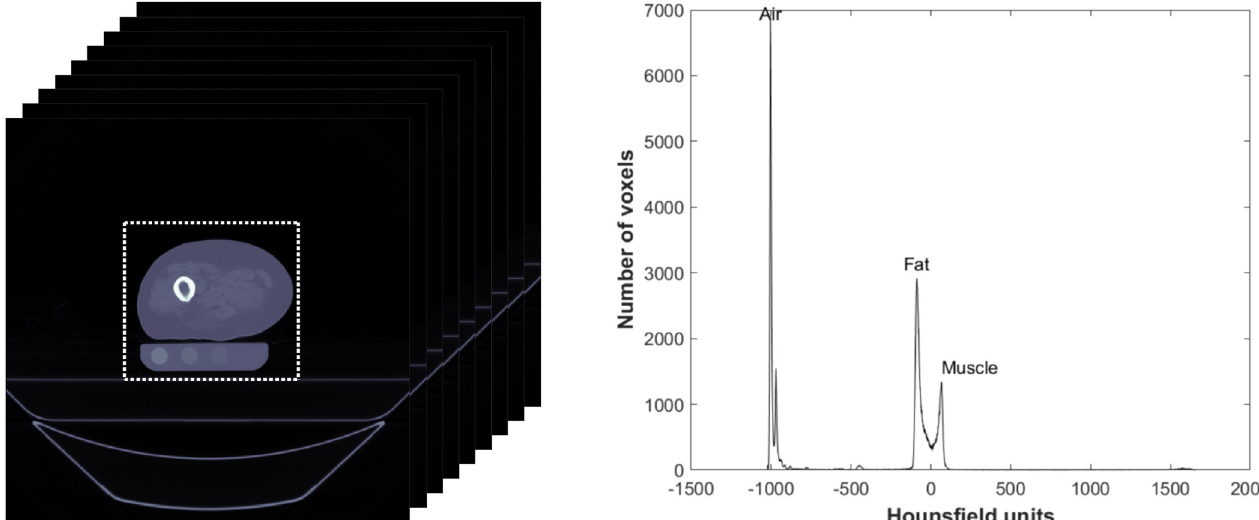
Fig 1. An example of the selected region of interest (left) and the histogram of the Hounsfield units within the region of interest with the peaks for air, fat, and muscle (right).